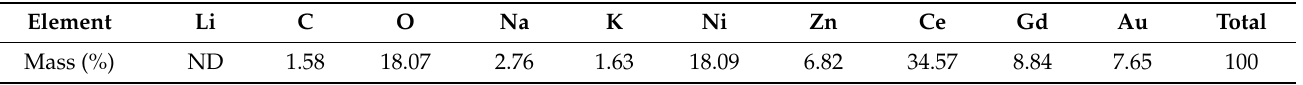
Table 3. Elemental concentration of the printed single-layer cell shown in Figure 7. ND represents “no data”.